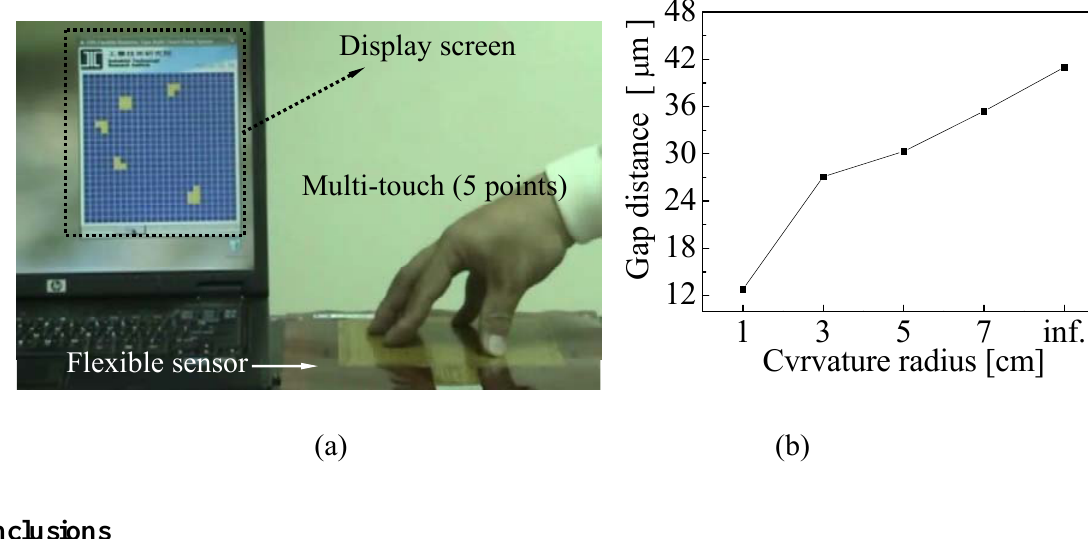
Figure 10. Performance testing, (a) Fingers used as input units to test multi-touch using the sensing algorithm matrix, and (b) bending testing at different curvature radii of 1, 3, 5, 7, and inf.